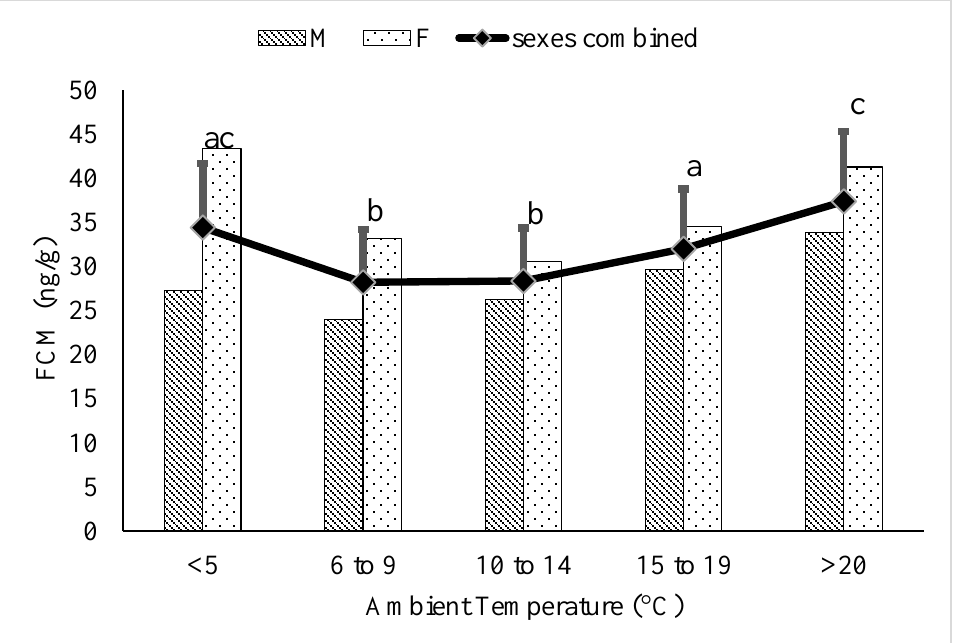
Figure 3. Back-transformed LSMeans ± SEM for fecal cortisol metabolite (FCM) concentrations (ng/g dry feces) within different ambient temperature categories for adult (6–17 years) polar bears (N samples = 3815). Different subscripts represent differences between temperature categories ( p < 0.05). Columns represent sex-specific back-transformed LSMeans for each temperature category.